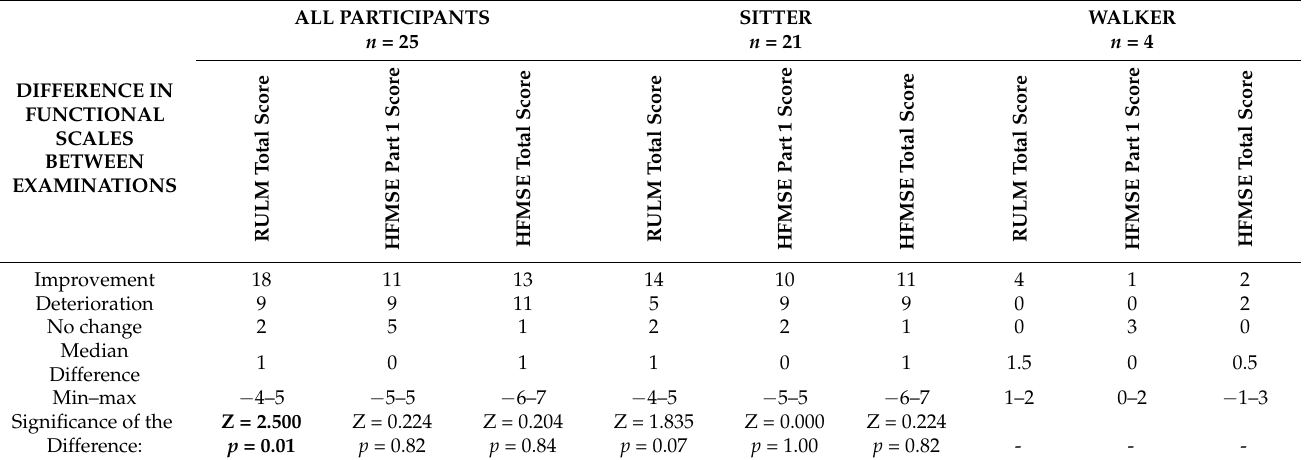
Table 3. Changes in the RULM and the HFMSE scales after 12-months of observation in all of the studied children and in the functional subgroups (sitter, walker). Statistically significant difference is marked in